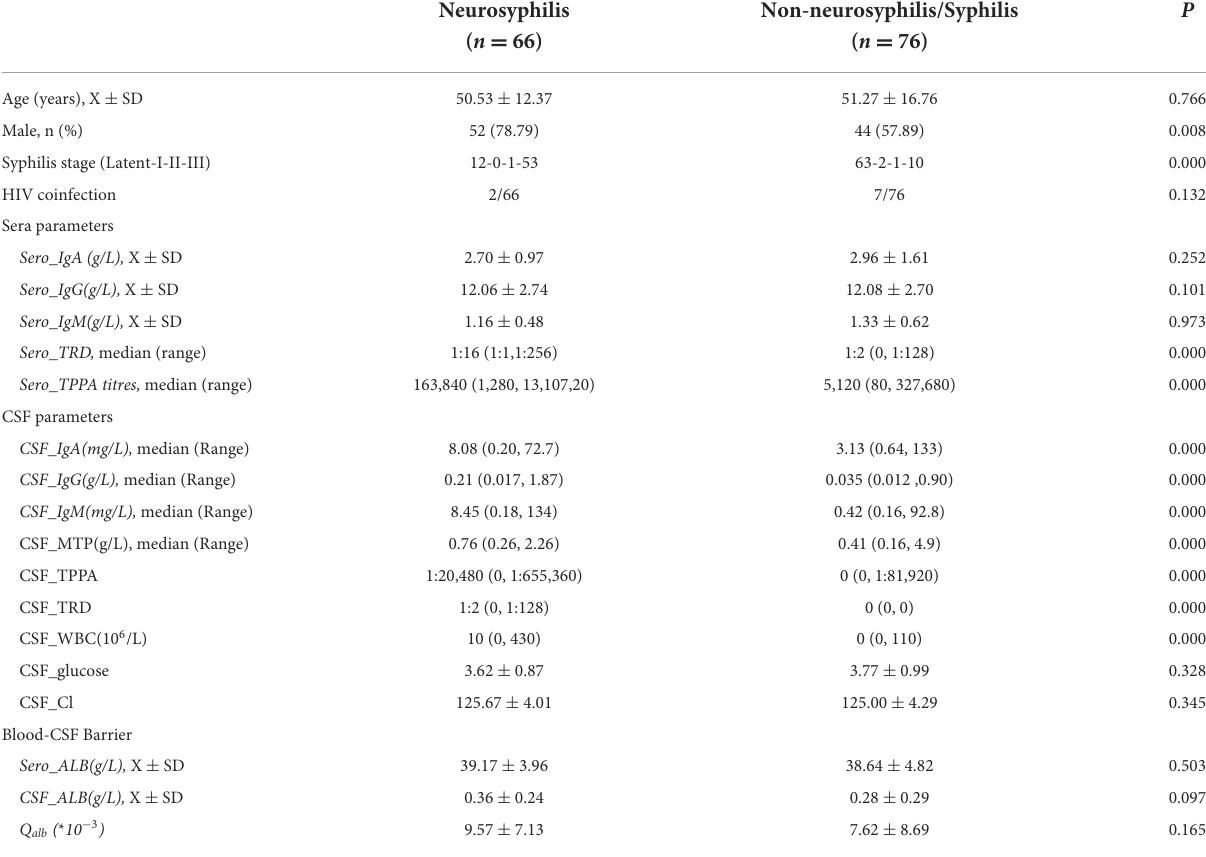
TABLE 1 Characteristic of the study